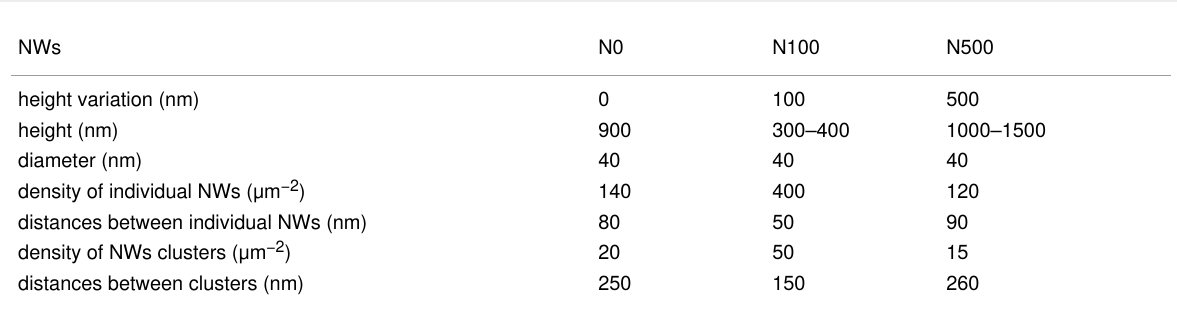
Table 1: Parameters of three investigated GaN NWs